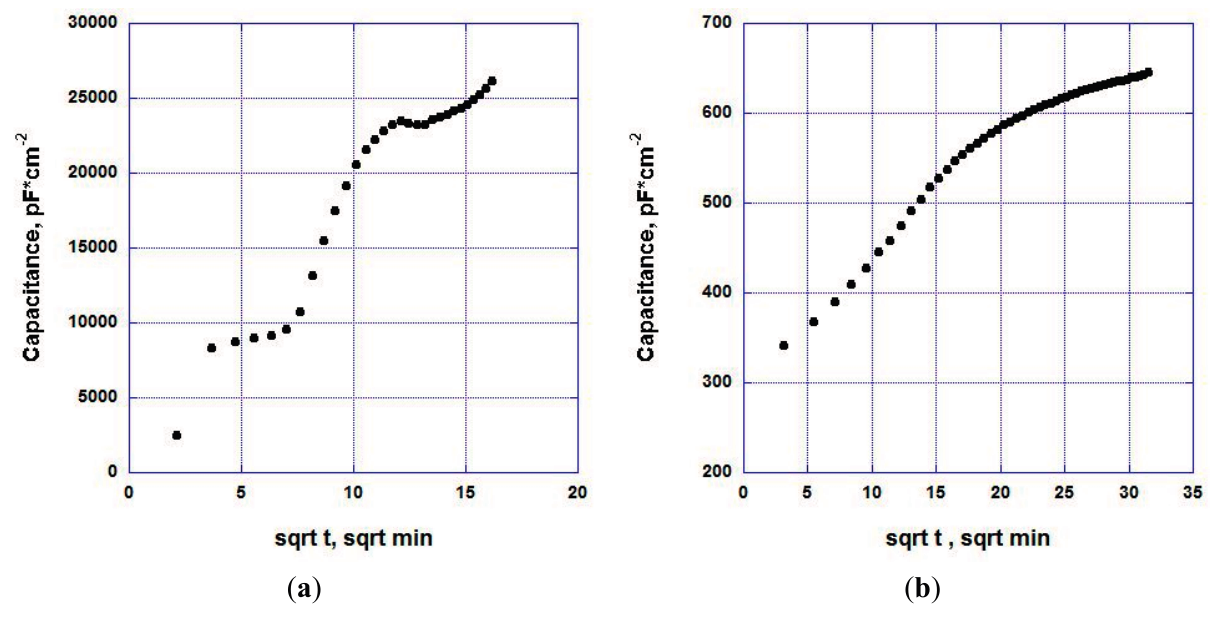
Figure 6. Capacitance curve for sample coated with unfilled water-based epoxy resin ( a ) and graphene/epoxy resin ( b